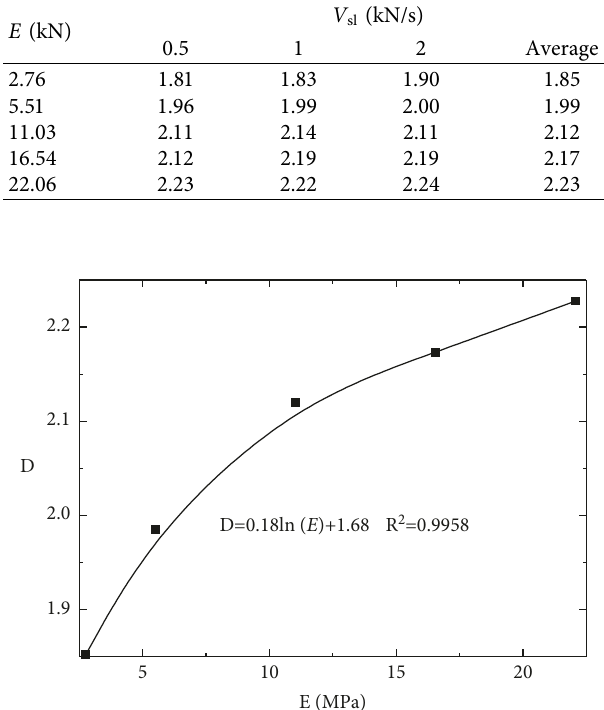
Figure 5: Variation of fractal dimension of particle size with maximum